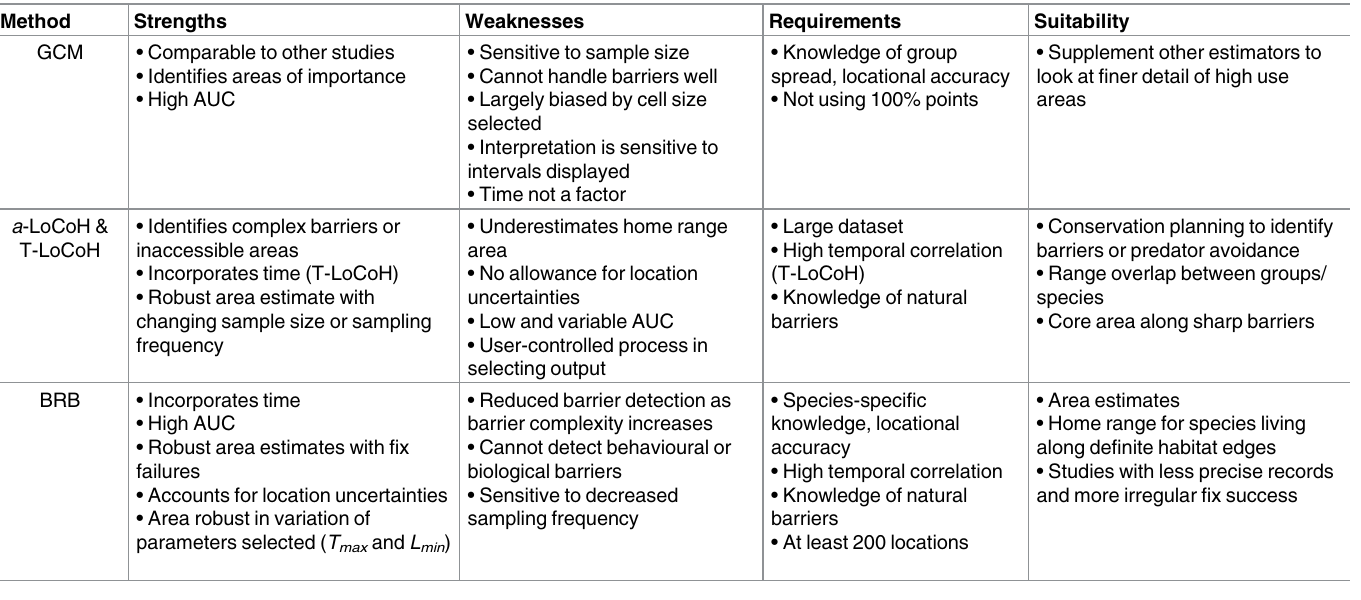
Table 3. Summaryof the strengths and weaknesses of the home range estimators examined in this study. Method